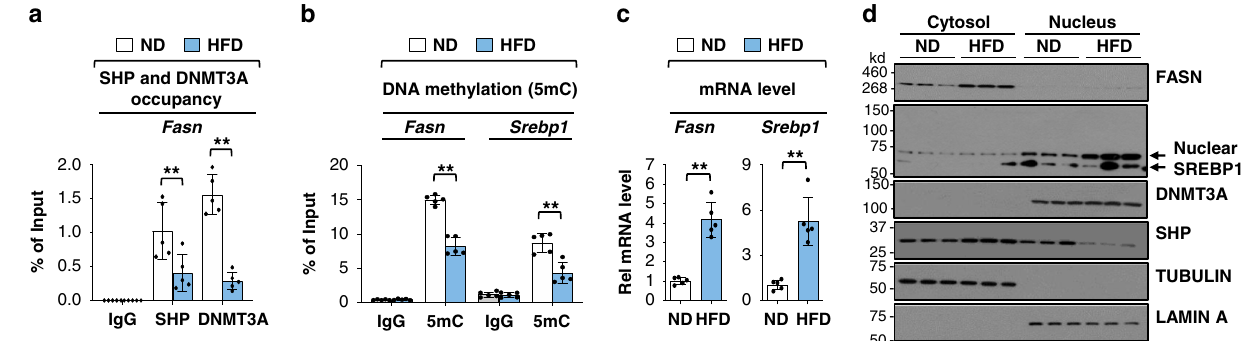
Fig. 8 In obese mice, occupancy of SHP and DNMT3A and DNA methylation at lipogenic genes are low, with elevated gene expression. C57BL/6 mice were fed a HFD for 12 weeks. a SHP and DNMT3A occupancies at the promoter of hepatic Fasn determined by ChIP. b Methylated DNA at the Fasn promoter determined by MeDIP. c Levels of Fasn mRNA measured by RT-qPCR. d FASN and SREBP1 protein levels in whole cell liver extracts determined by IB. Results from two mice in each group are shown and the IB analysis was done once. a – c The mean values ± SD are plotted ( n = 5 mice). Statistical signi fi cance was determined by ( a , b ) two-way ANOVA with the Tukey post-test or ( c ) two-tailed Student ’ s t test. ** P <